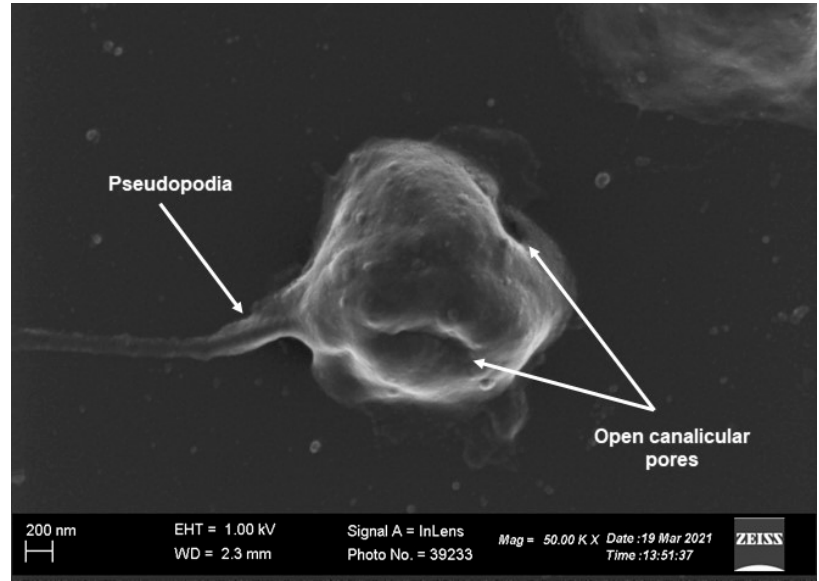
Figure 2. Scanning electron microscopy image of a platelet indicating normal morphology. The discoid, compacted structure of the platelet points to the platelet being at rest with well-defined open canalicular pores that communicate with the extracellular environment (scale indicates 200 nm) [7–12].